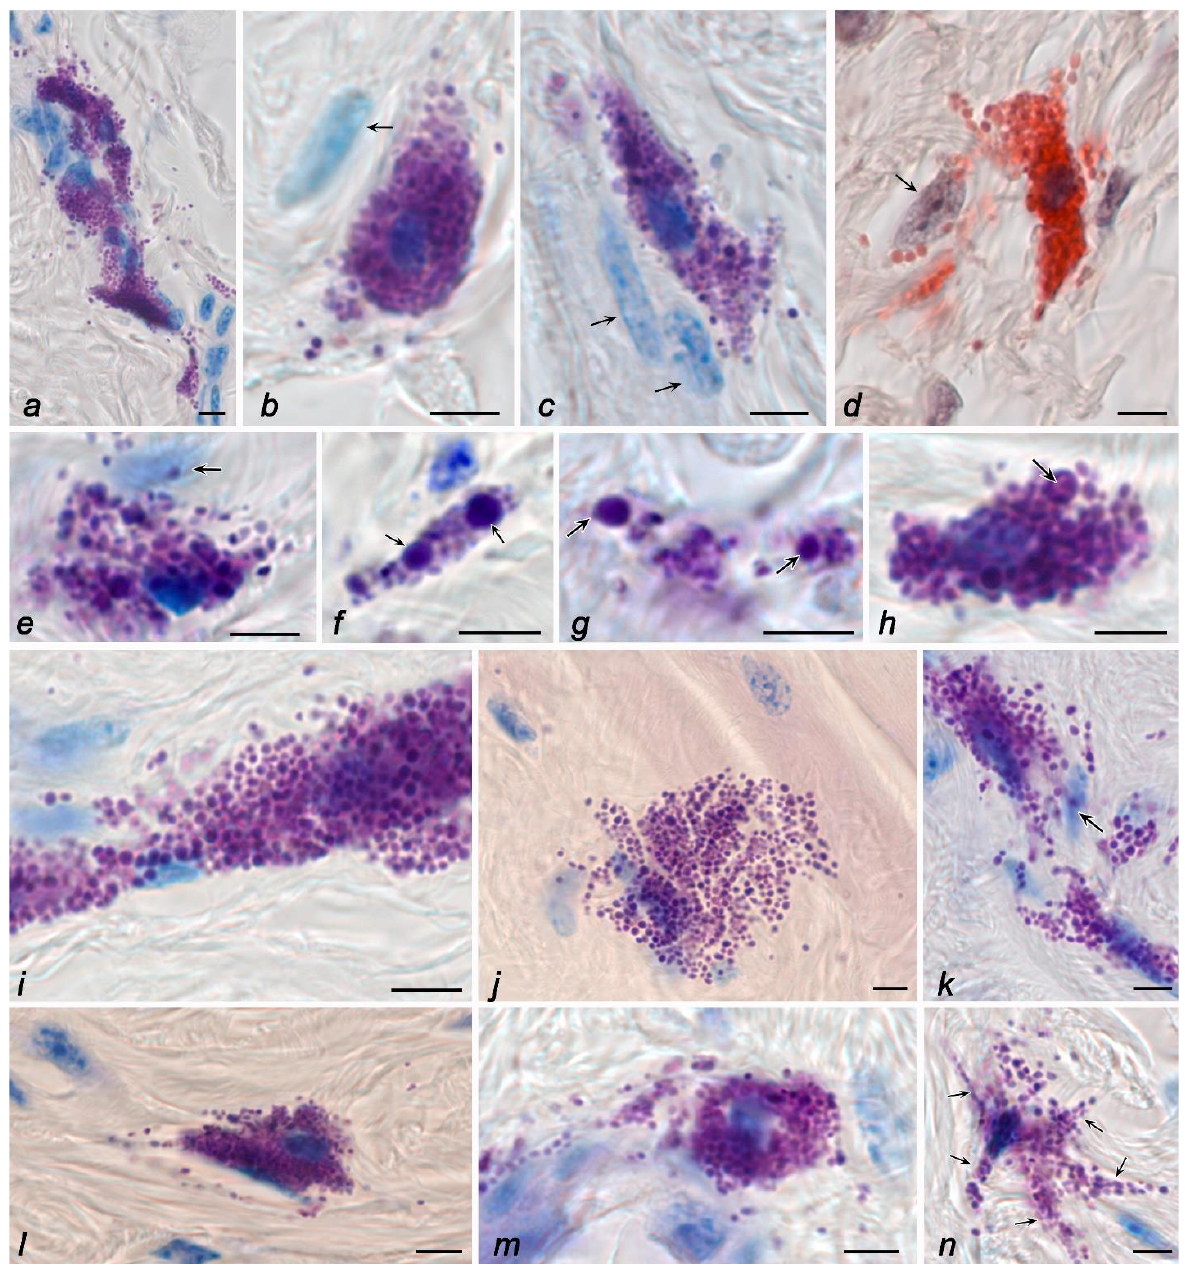
Figure 2. The mast cells in the skin of the thigh of C57BL/6J mice. Groups of basal ( a , d , h ), vivarium ( b , g ), and ground ( c , e , f ) controls, and space flight ( i – n ). Techniques : staining with toluidine blue ( a - c , e – i , k , m , n ), Giemsa solution ( j , l ), and detection of chloroacetate esterase activity ( d ). Notes: ( a ) Fi- broblast-associated mast cells form a multicellular fibrillogenic cluster. Active excretion of mast cell secretome into the extracellular matrix. ( b – e ) Co-localization of mast cells and secretory granules with fibroblasts (indicated by an arrow). ( f , g ) Location of secretory granules in the extracellular ma- trix of the connective tissue of the skin dermis, including large-sized granules (indicated by an ar- row). ( h ) Loss of secretome metachromacy in the central region of a large mast cell granule during secretion (indicated by an arrow). ( i , k ) Increased secretory activity of contacting mast cells. ( j ) Large